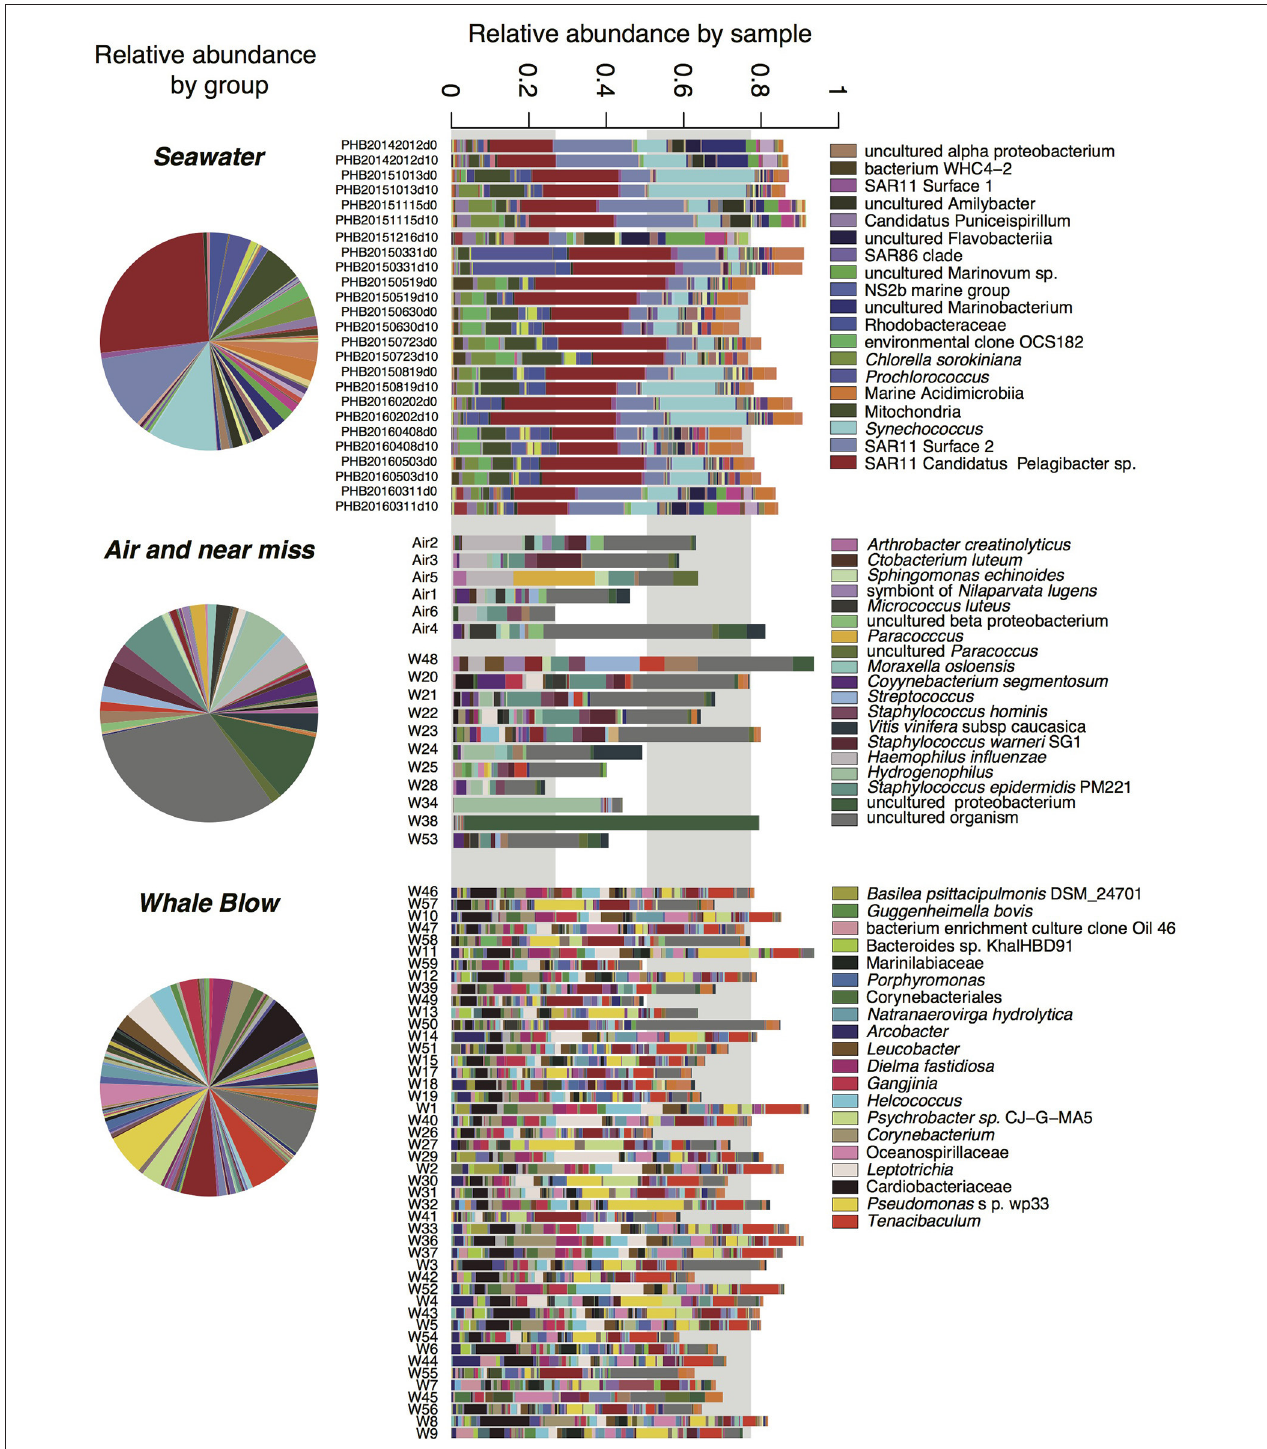
FIGURE 4 | Relative abundance of bacterial taxa identified in seawater, UAV captured air and whale blow. OTUs with abundance < 9 across the entire dataset were omitted for clarity. Relative abundances are presented for each group (i.e., seawater, air plus “near-miss” samples and whales, as well as for each sample. Taxa names correspond to the highest taxonomic level identification, full taxonomies are present in Supplementary Tables 3–6) only the top taxa by abundance are shown in the legend.